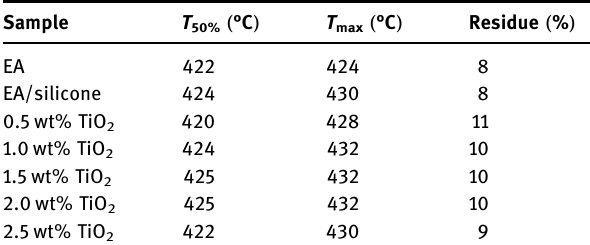
Table 1: Thermogravimetric data of TiO 2 - modi fi ed resin Sample